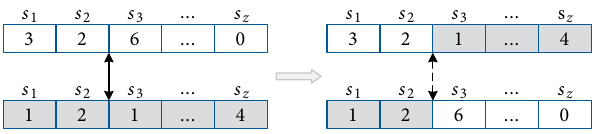
Figure 2: An instance of crossover operation.